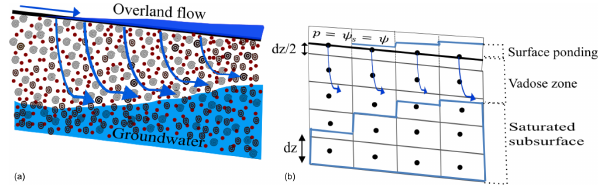
Figure 1. Coupled surface and subsurface flow systems. The physi- cal system is represented in (a) , and a schematic of the overland flow boundary condition (continuity of pressure and flux at the ground surface) is in (b) . The equation p = ψ s = ψ in Fig. 1 signifies that at the ground surface, the vertically averaged surface pressure and subsurface pressure head are equal, which is the unique overland flow boundary used by